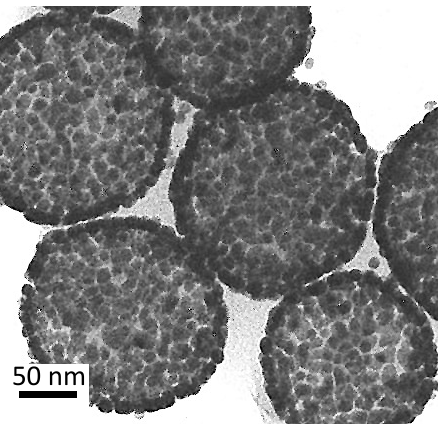
Figure 7. TEM image of nanoshells prepared by seeding gold nanoparticles onto a silica core, followed by a second reduction of gold chlorate to create a continuous gold film. Adapted from [78], published by ACS,